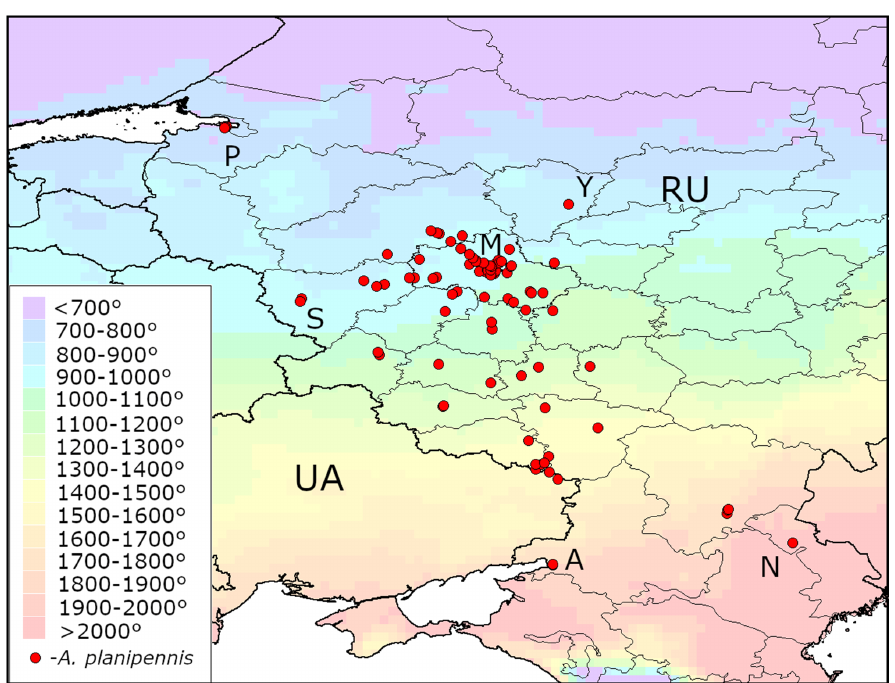
Figure 3. Heat availability in the current range of Agrilus planipennis in European Russia and Ukraine. Mean AGDD 10 per year in 2003–2020 is indicated with colours (see the legend). RU—Rus- sia, UA—Ukraine. The information about occurrences of A. planipennis was obtained from recent publications [9,19]. Some occurrences are indicated with letters: A—Azov, M—Moscow, P—Saint Petersburg, S—Smolensk, Y—Yaroslavl, N—Nikolskoe Village (Astrakhan Region). The new occur- rence in Azov is published for the first time. The distribution of A. planipennis in its native range is not only limited by distribution of its host plants [12]. The host plant of A. planipennis in Asia, Fraxinus mandshurica Rupr., [28] occurs on the Sakhalin Island, some districts of Primorye Territory and Khabarovsk Territory, although A. planipennis is absent there [29] (Figure 4). The minimum heat avail- ability (AGDD 10 ) in grid squares occupied by F. mandshurica is 574°, while A. planipennis has been never recorded in the grid squares with AGDD 10 below 700°. It indicates that heat availability could be one of the factors limiting the distribution of A. planipennis in the north of its range.